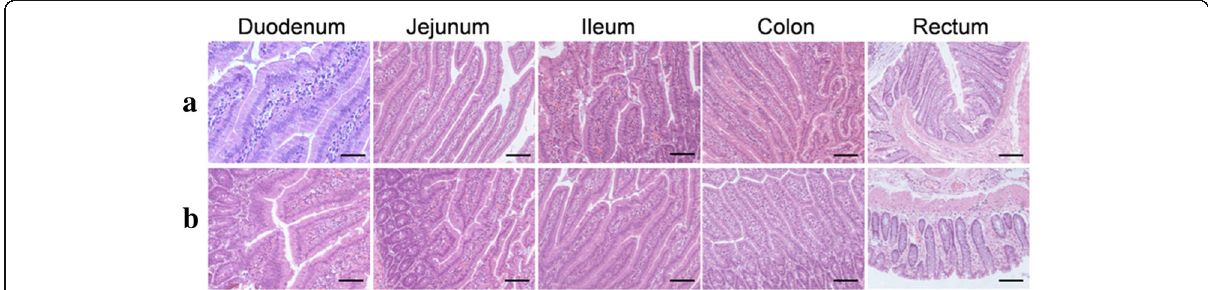
Fig. 3 Histopathological microsection of different intestinal tissue samples of mice with CBD ligation. a Control groups: mice treated with saline injection via tail veins (upper panels). b Test groups: mice treated with triangular silver nanoplates suspension injected via tail veins (lower